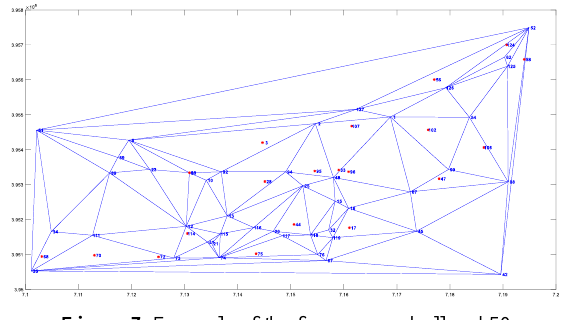
Figure 7. Exemple of the four convex hull and 50 complementary points triangulation (triangles vertexs) with 20 check points (in red).